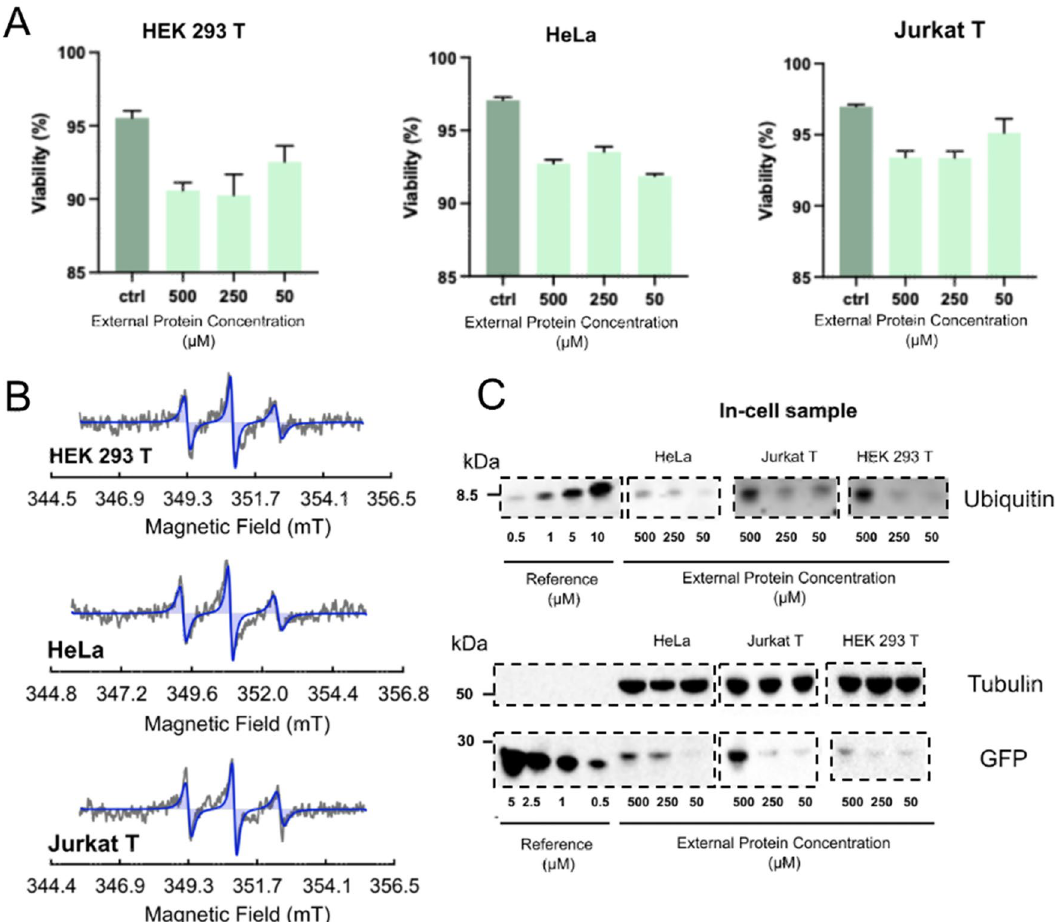
Figure 2. ( A ) Viability assay conducted using the 5-5 HS delivery setup in presence of variable external Ubiquitin protein concentrations. ( B ) grey-cw-EPR spectra acquired at RT on HeLa, HEK 293 T and Jurkat T cells where ubiquitin A28C ma-Px-spin labelled was delivered using the 5-5 delivery scheme and an external protein concentration of 500 μM. Blue-cw-EPR spectra acquired for an in vitro reference sample of ubiquitin A28C ma-Px-spin labelled protein at 100 μM. ( C ) In-gel fluorescence PAGE and Western blot assay conducted on Ub A28C-atto488 and GFP delivered cells using the 5-5 delivery setup. In each assay references at known concentrations were used (Supplementary Information, Experimental Methods, Figs. S1–S3). All gels reported in this figure have been selected from the raw gels reported in the Supplementary (Ub-A28C-atto-488), were delivered (Supplementary Information, Experimental Methods, Figs. S1–S3). This analysis estimated the bulk concentration of the internalized protein to be in the range of 0.1–3.5 µM for the various external protein concentrations (Fig. 3 and Supplementary Information, Figs. S1–S3). High-resolution confocal fluorescence microscopy (Fig. 3) and Z-stack reconstruction (Supplementary Information, Experimen-